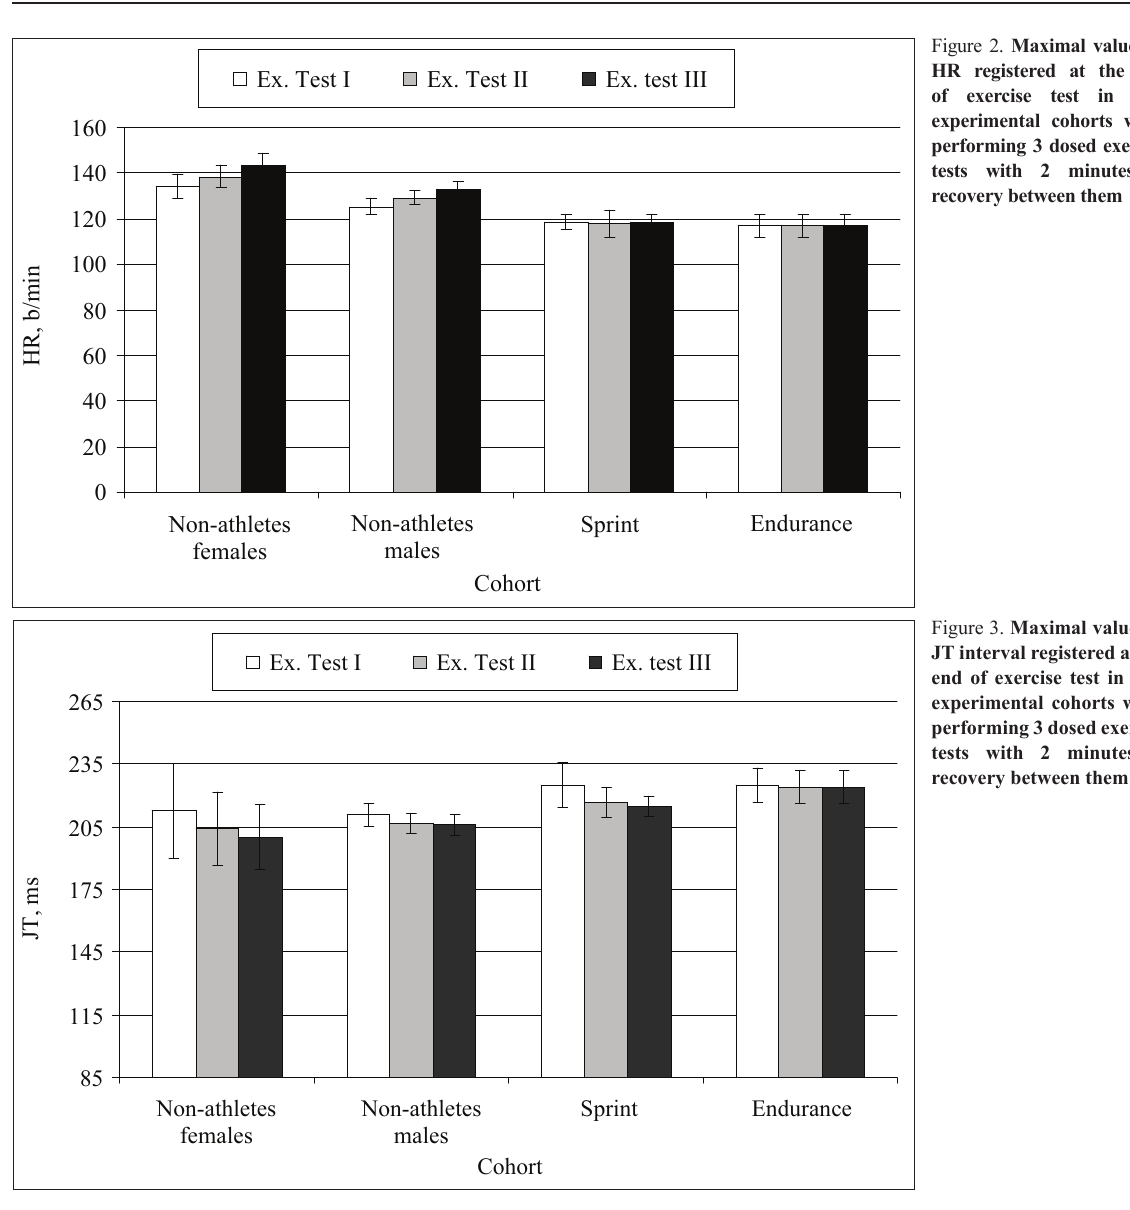
Figure 3. Maximal values of JT interval registered at the end of exercise test in four experimental cohorts while performing 3 dosed exercise tests with 2 minutes of recovery